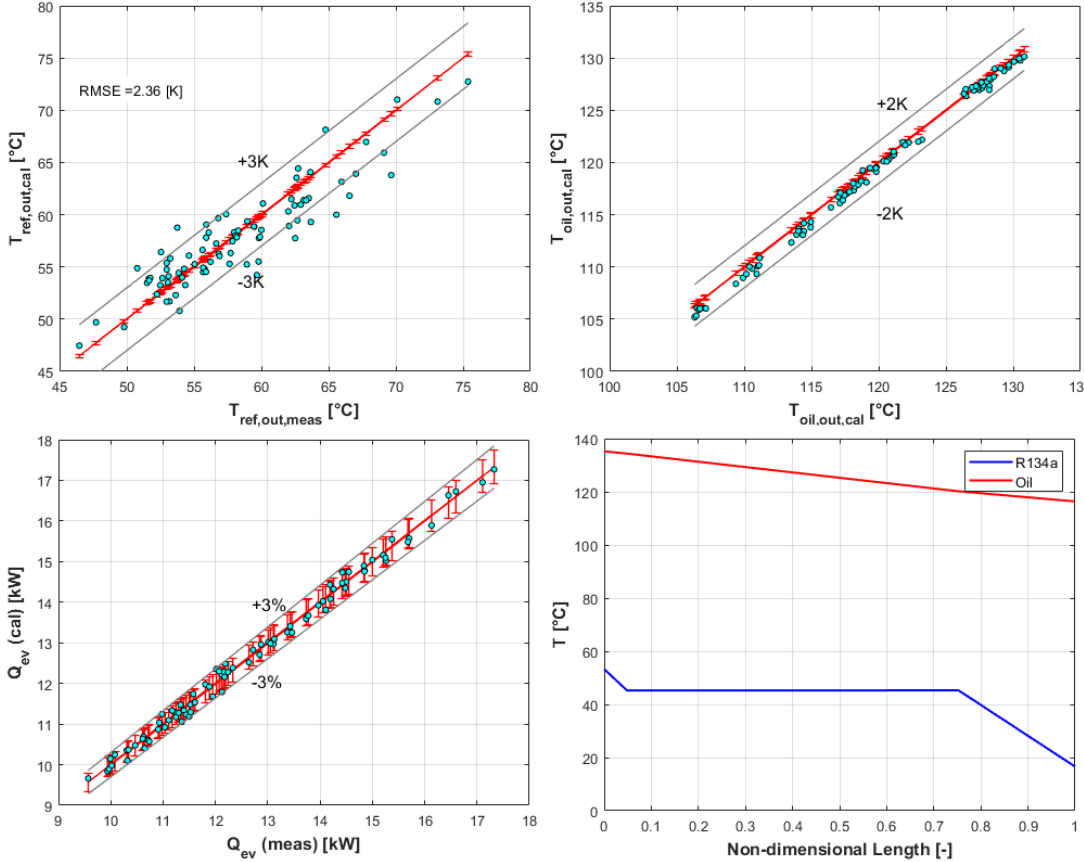
Figure 20. Results of the evaporator hydrothermal model vs. experimental data: refrigerant discharge temperature ( top-left ), diathermic oil discharge temperature ( top-right ), thermal load in the refrigerant side ( bottom-left ), and temperature profile for one of the experimental points ( bottom-right